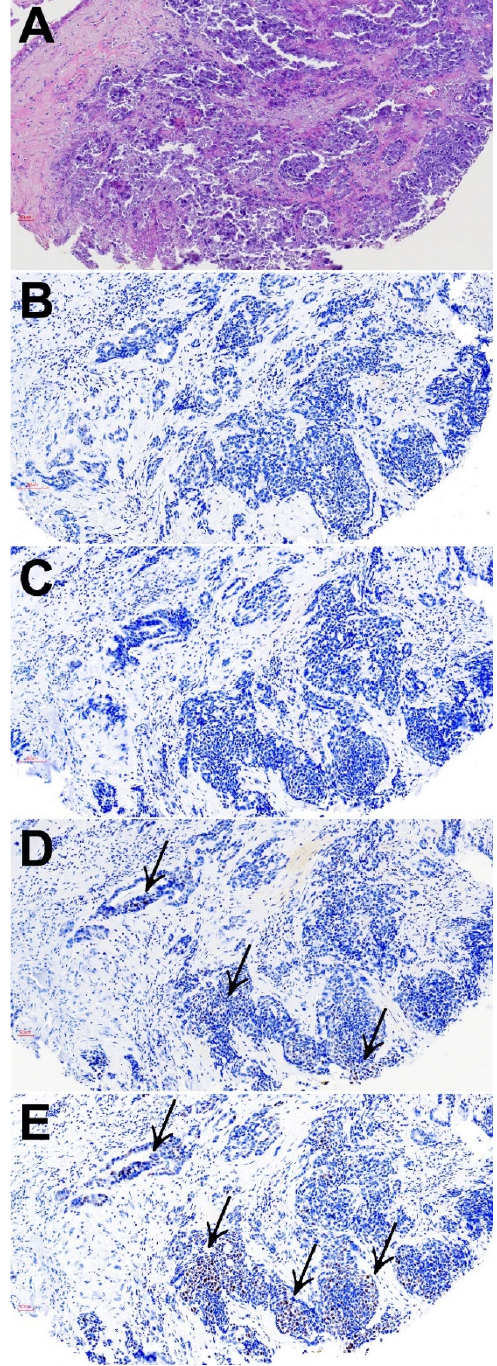
Figure 5. Representative MSI-positive SNUC showing stainings of hematoxylin and eosin ( A ), PMS2 ( B ), MLH1 ( C ), MSH2 ( D ) and MSH6 ( E ). Arrows indicate small patches of positive cells. All images × 200